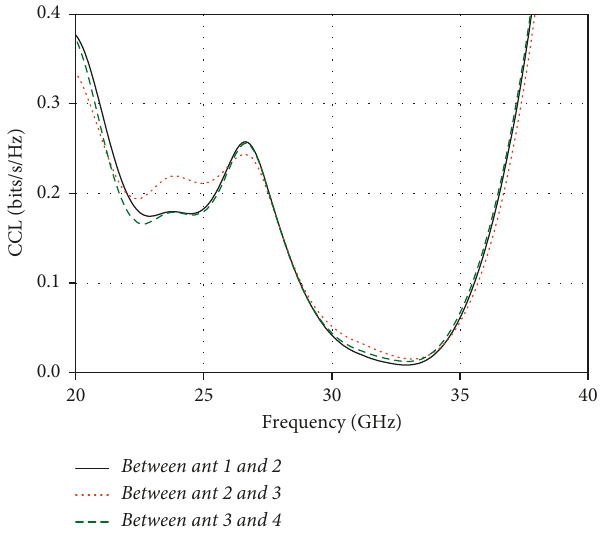
Figure 20: Calculated CCL (bits/s/Hz) between antennas 1 and 2, 2 and 3, 3 and